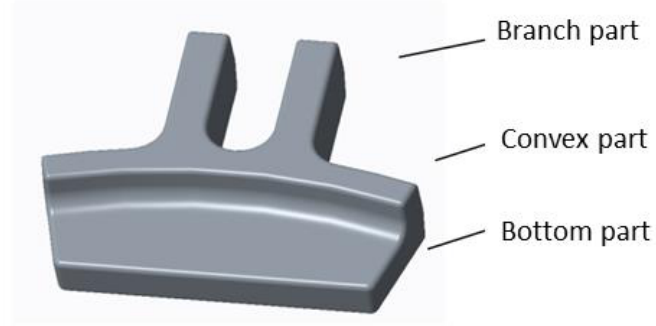
Figure 5. Illustration of solid rocket motor forging part.